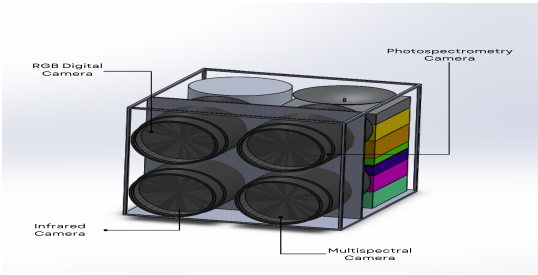
Figure 1. System camera deployment.